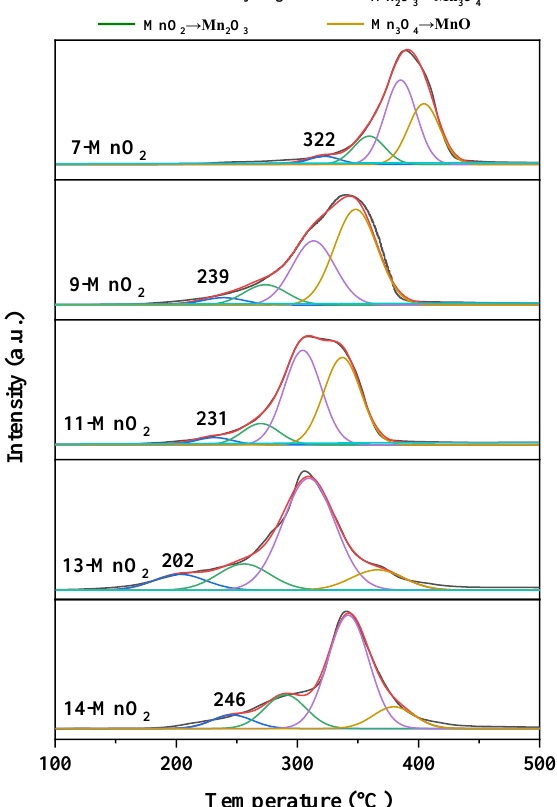
Figure 8. H 2 -TPR diagram of five catalysts.